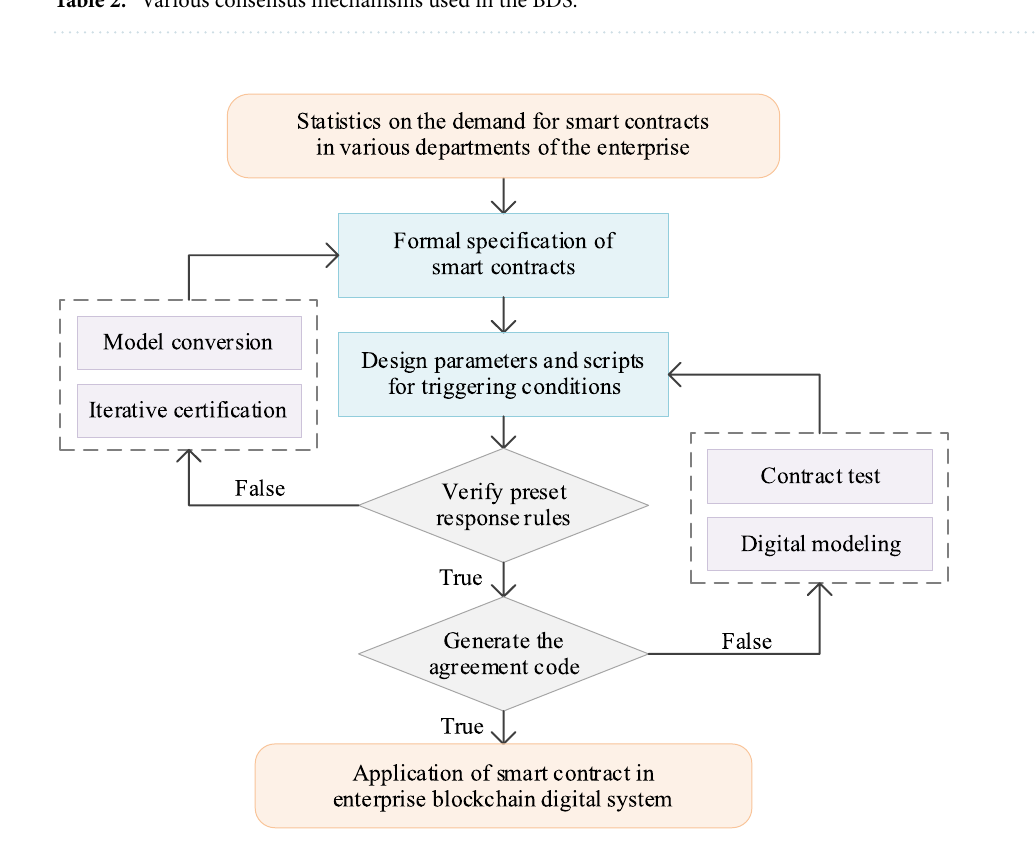
Table 2. Various consensus mechanisms used in the BDS.